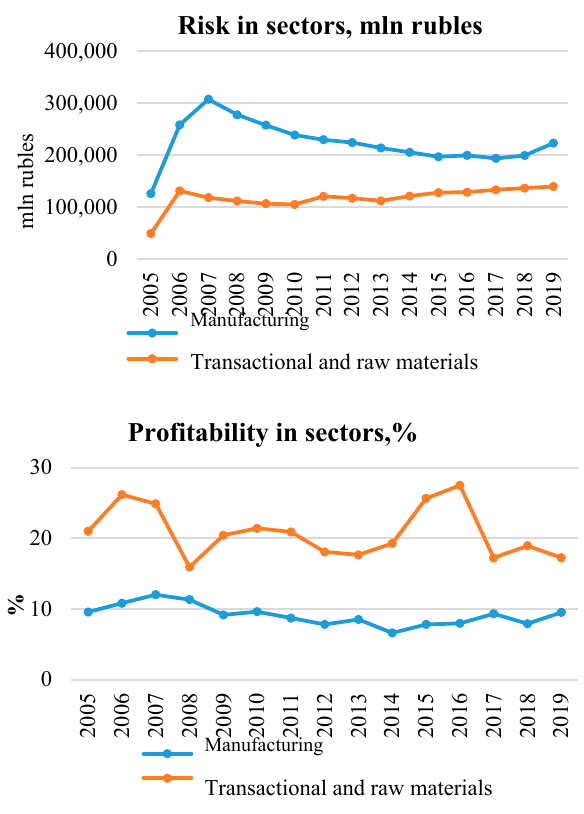
Figure 10. Risk (above), profitability (below) by sector in the Russian economy, 2005–2019 8 .